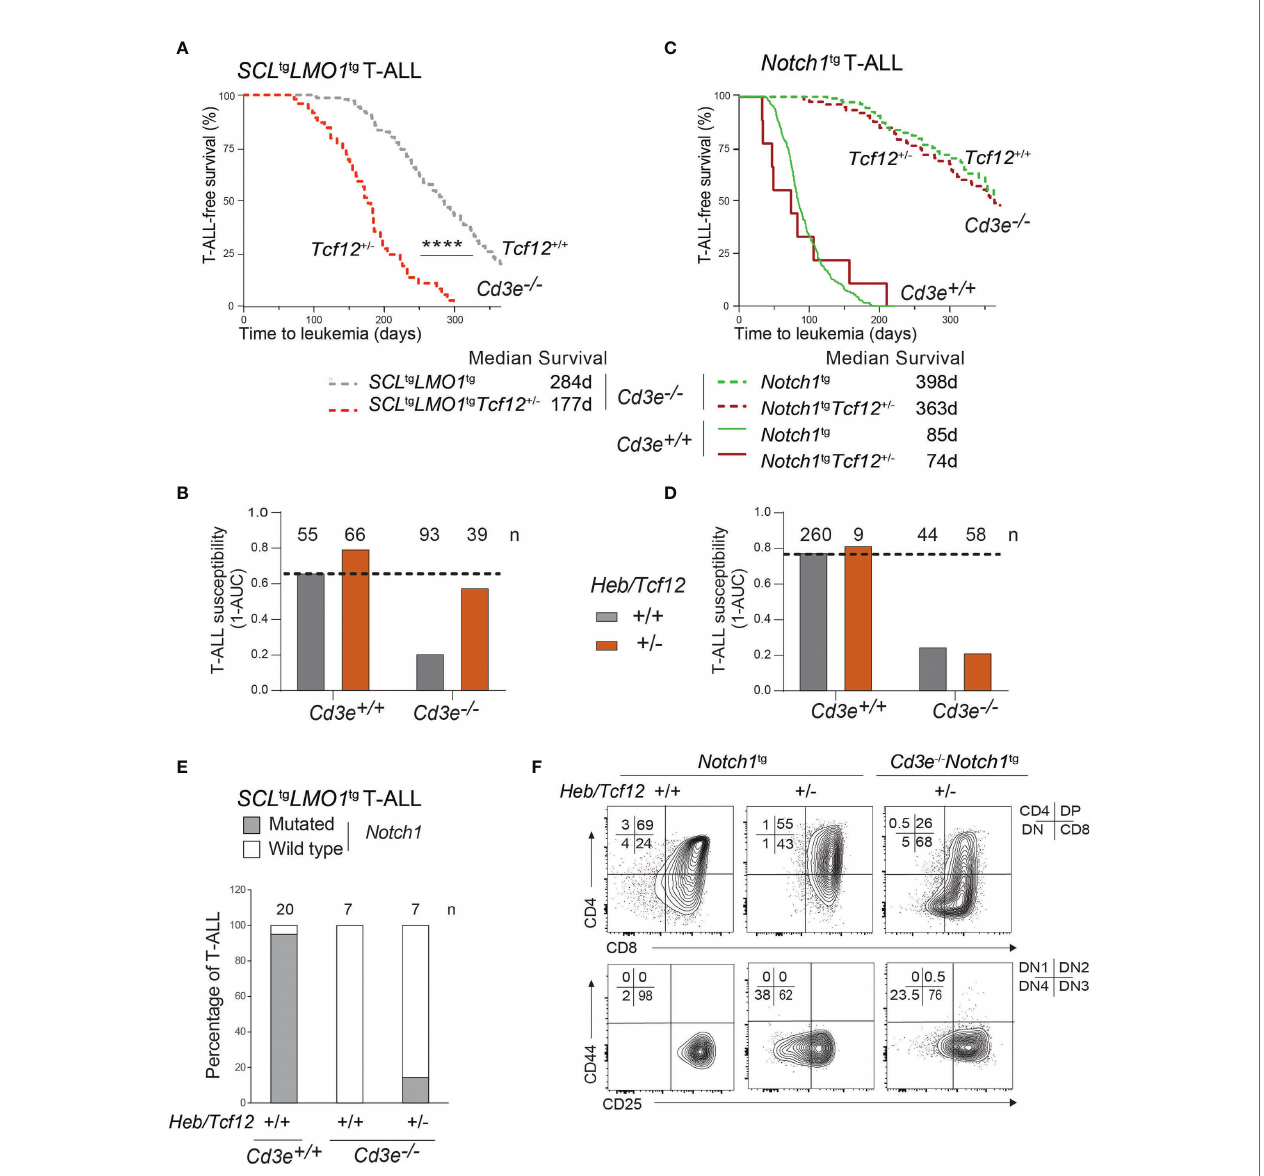
FIGURE 5 | The SCL and LMO1 oncogenes but not the Notch1/IC9 oncogene reveal Heb/Tcf12 as a haplo-insuf fi cient tumor suppressor in T-ALL. (A) Kaplan-Meyer survival curves comparing Cd3e -de fi cient SCL tg LMO1 tg leukemias in Heb/Tcf12 +/+ and Heb/Tcf12 +/- backgrounds. Shown is the median survival in days. (B) T-ALL susceptibility of SCL tg LMO1 tg mice in Cd3e -pro fi cient ( Cd3e +/+ , Figure 3C ) or de fi cient ( Cd3e -/- , Figure 5A ) backgrounds was calculated from the area under the curve (AUC) of the above Kaplan-Meyer graph over 365 days. Shown on top are the numbers of mice per group. (C, D) Kaplan-Meyer survival curves (C) and T-ALL susceptibility (D) comparing Notch1/IC9- induced leukemias in Heb/Tcf12 +/+ and Heb/Tcf12 +/- backgrounds that are Cd3e -de fi cient or Cd3e -pro fi cient. (E) Presence of Notch1 activating mutations in Cd3e -pro fi cient but not Cd3e -de fi cient SCL tg LMO1 tg T-ALL. Shown are the percentage of T-ALL samples with an activating mutation in the Notch1 locus in Heb/Tcf12 +/+ and Heb/Tcf12 +/- backgrounds. Shown on top are the numbers of leukemias sequenced in each group. Only one Heb/Tcf12 +/- Cd3e -de fi cient SCL tg LMO1 tg T-ALL harbours a mutation affecting the PEST domain of Notch1. (F) Leukemic phenotypes of Cd3e -pro fi cient or Cd3e -de fi cient Notch1 tg leukemias from Heb/Tcf12 +/+ and Heb/Tcf12 +/- backgrounds ****